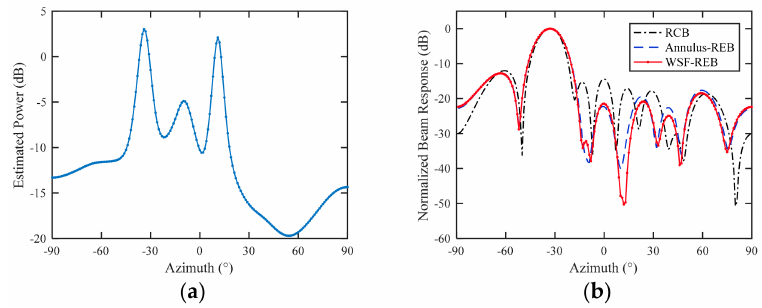
Figure 6. Experiment results. ( a ) Estimated Capon spectrum using assumed nominal SVs; ( b ) beam patterns of tested beamformers in the case of sensor position